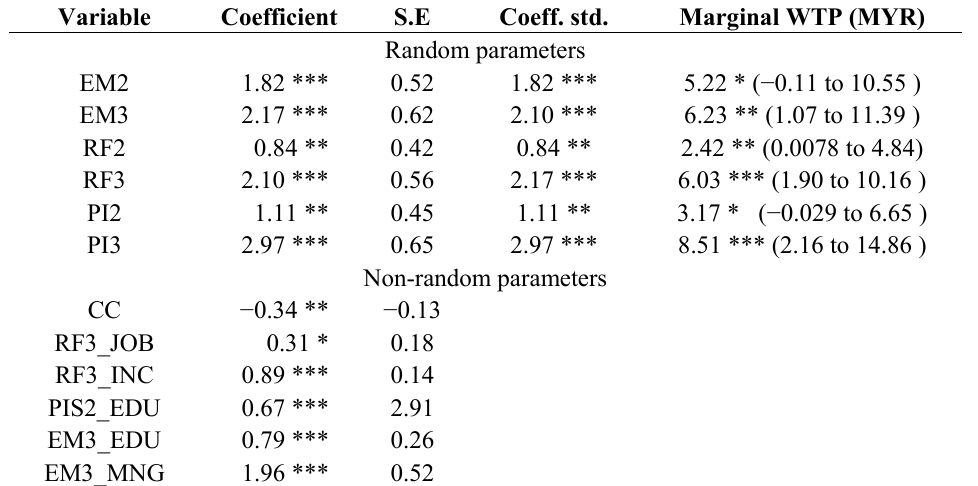
Table 6. Results of pooled RPL Model and